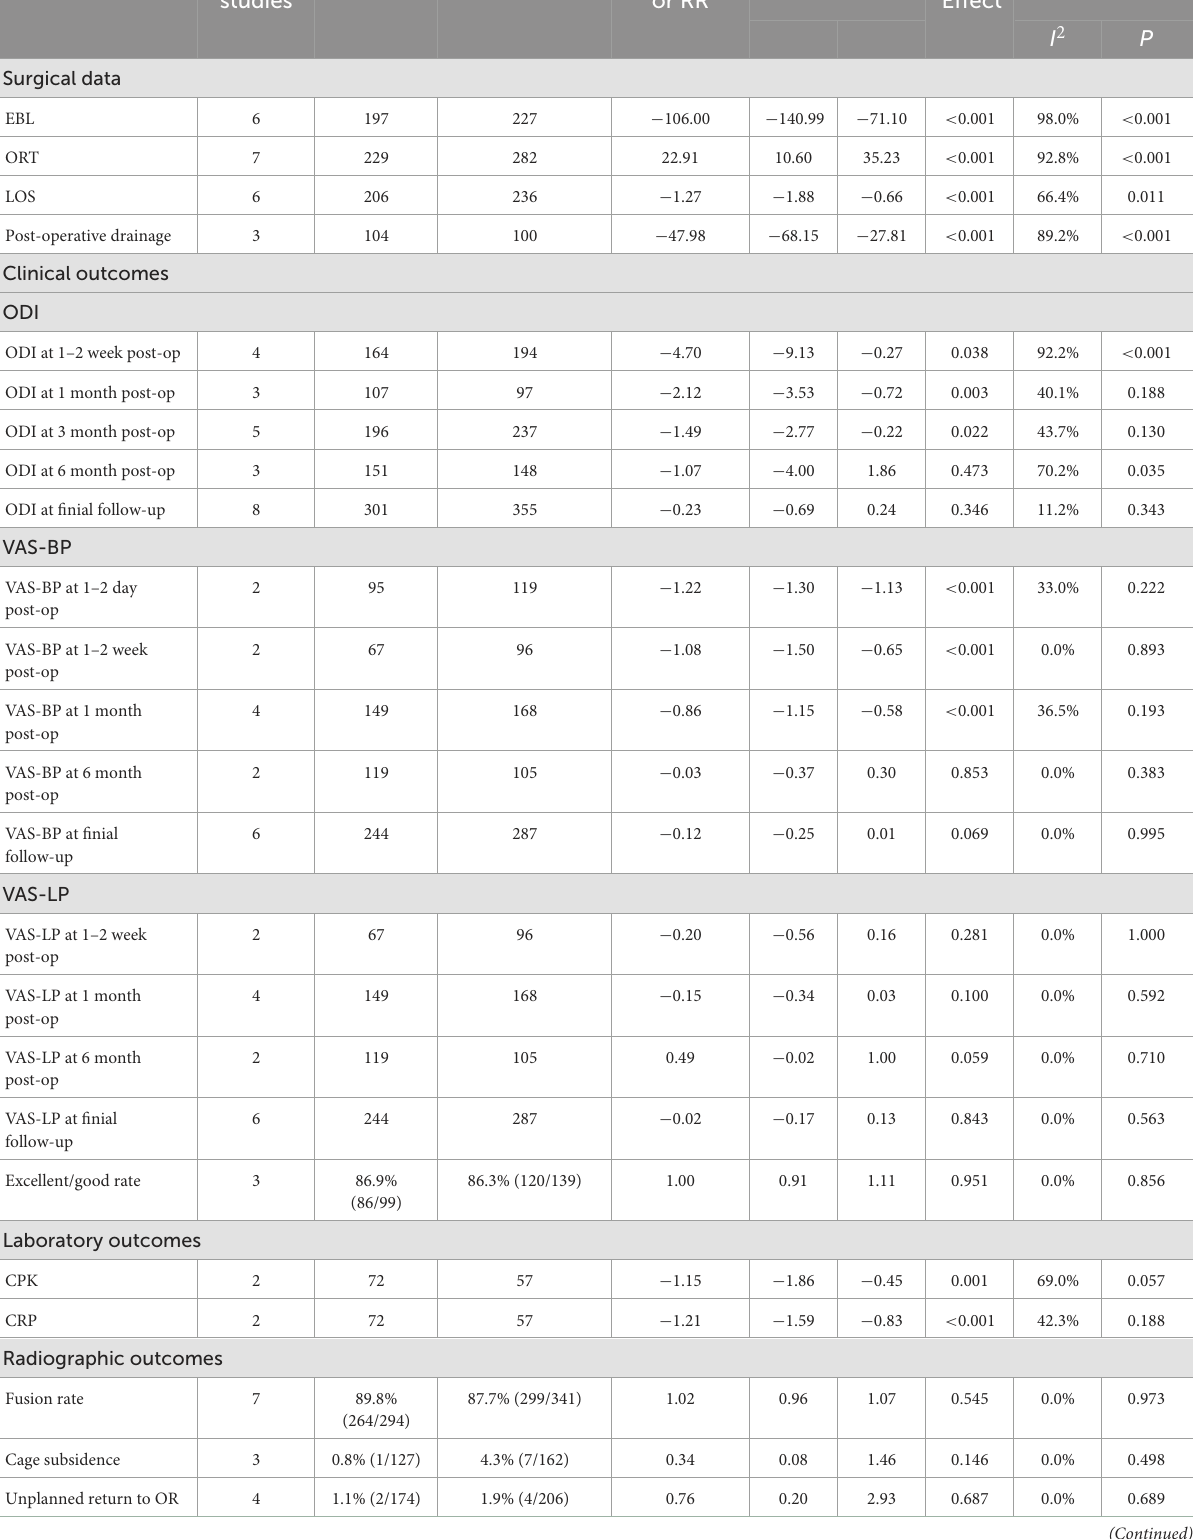
TABLE 3 The pooled outcomes between ULIF and MI-TLIF group. Outcomes Included ULIF ∗ MI-TLIF studies